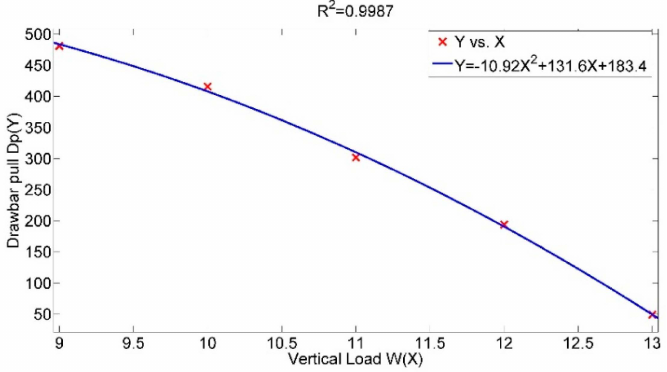
Figure 4. Drawbar pull with respect to vertical